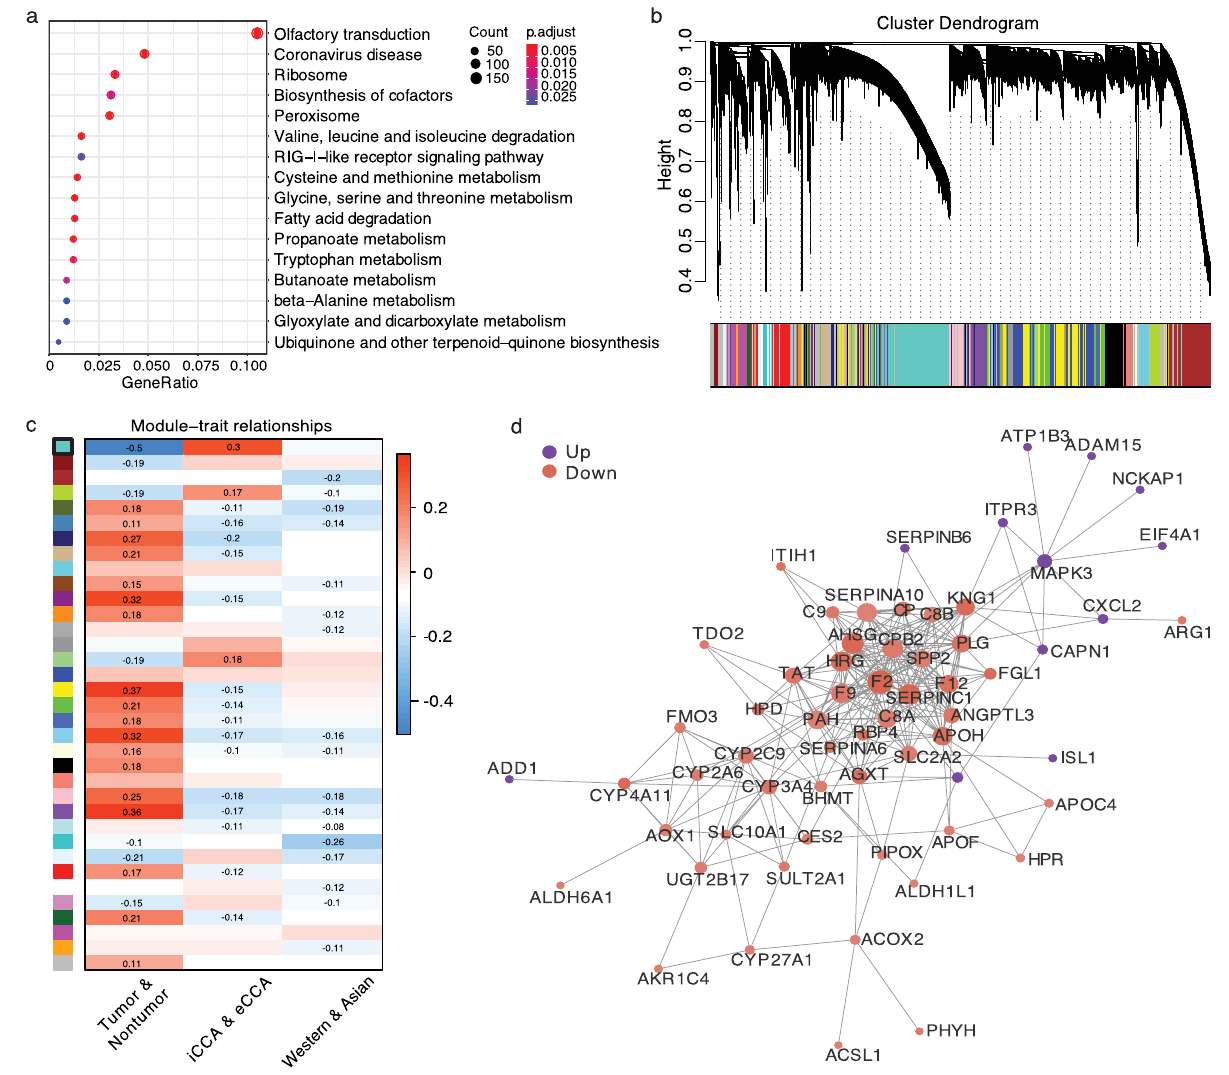
Figure 3. Network construction and module detection. ( a ) Functional enrichment analysis of DEGs by KEGG. The y-axis represents KEGG-enriched terms. The x-axis indicates the fold of enrichment. The size of each dot indicates the number of genes under a specific term. The color of the dots represents the adjusted p value. ( b ) Clustering dendrogram of genes with dissimilarity based on the topological overlap, together with assigned module colors using WGCNA analysis. ( c ) Illustration of association between modules and traits in WGCNA. Each row refers to a module eigengene, column to a trait. Module ‘turquoise’ is highlighted with black rectangle with the highest association coefficient. ( d ) PPI network of the DEGs within the selected module. The nodes represent each gene with edges mean the interactions. Purple and red means gene upregulation and downregulation,